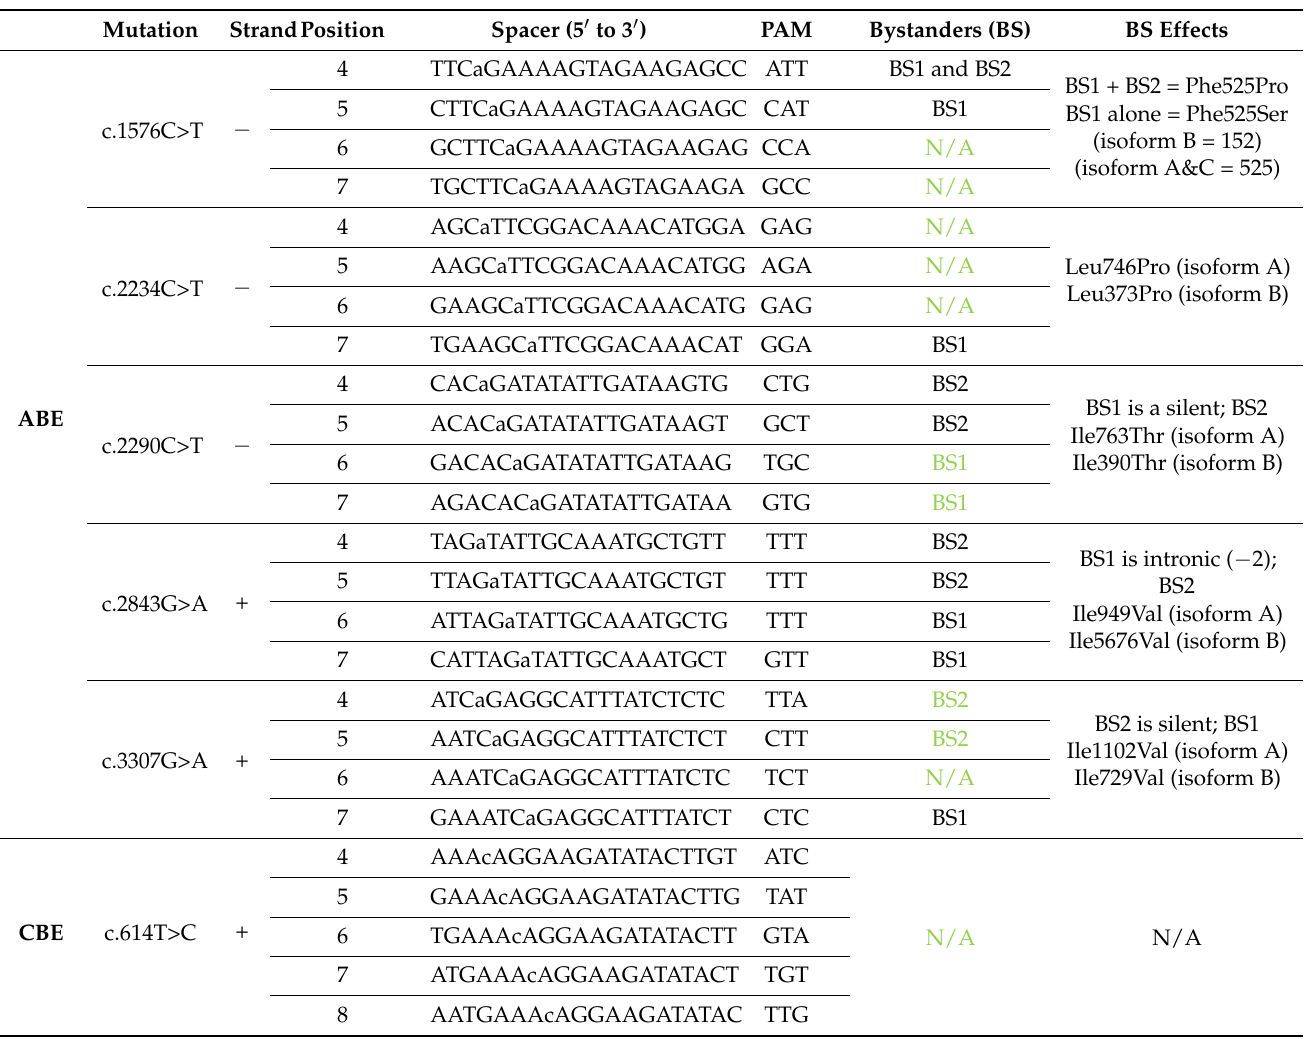
Table 3. Base editing design for the six transition mutations within the top 10 most frequent CRB1 variants in the Leiden Open Variation